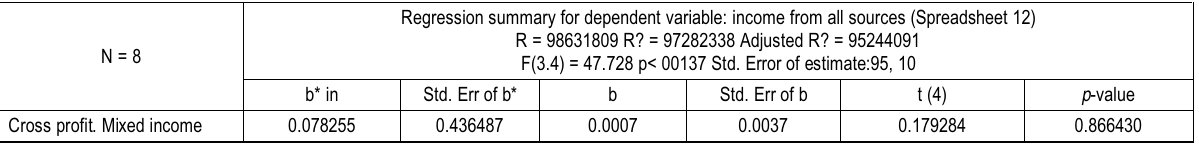
Table 5 (cont.).The results of correlation and regression analysis in the Statistica system